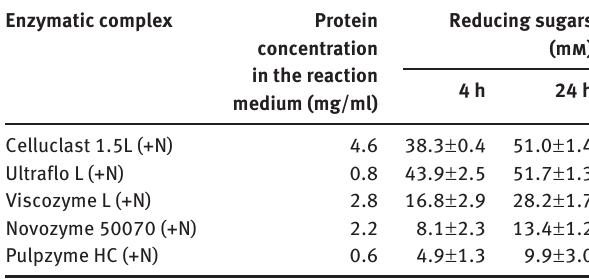
Table 2 Enzymatic saccharification of regenerated corn cob by means of different enzymatic